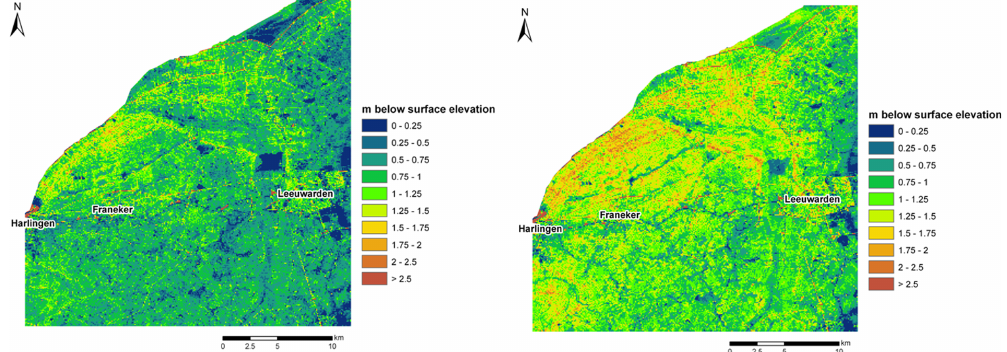
Fig. 15. Phreatic groundwater level in the winter (left panel) and in the summer (right panel), both in 2005.